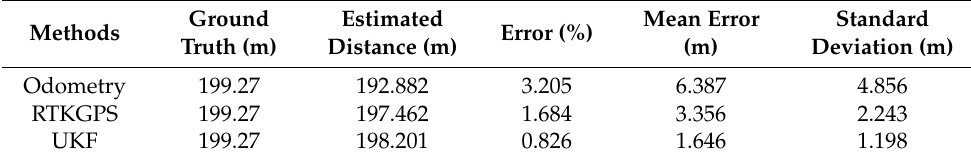
Table 2. Comparison of Travel Distances Using Odometry, RTKGPS, and UKF.